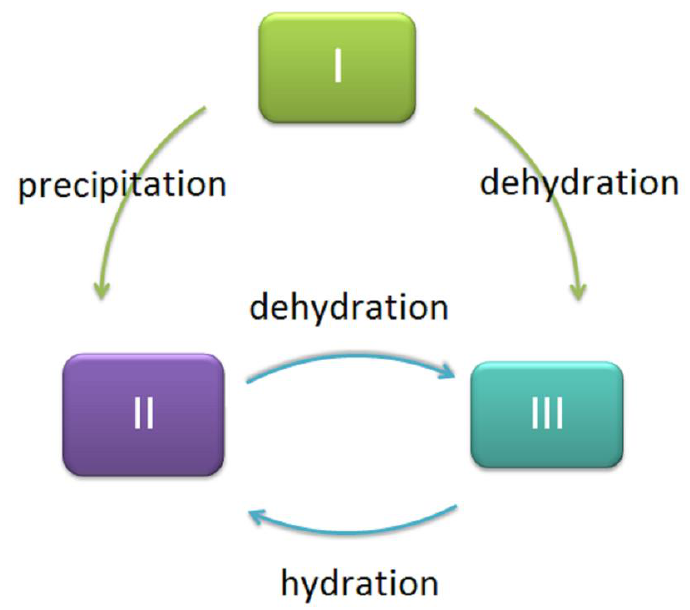
Figure 2. Mutual transformations of crystalline / polymorphic forms of (1 → 3)- α - d -glucans, based on Jelsma et al. [13].